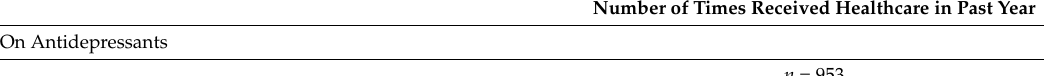
Table 5. Coefficients and levels of significance for the association between use of antidepressants and general access to